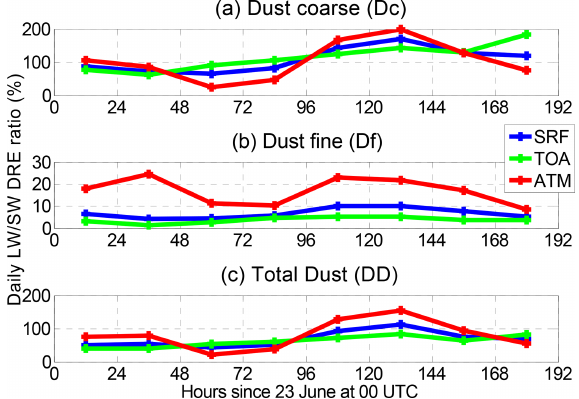
Figure 8. Daily LW / SW DRE ratio in BCN at the SRF, TOA and in the atmosphere (ATM) for (a) Dc, (b) Df and (c)